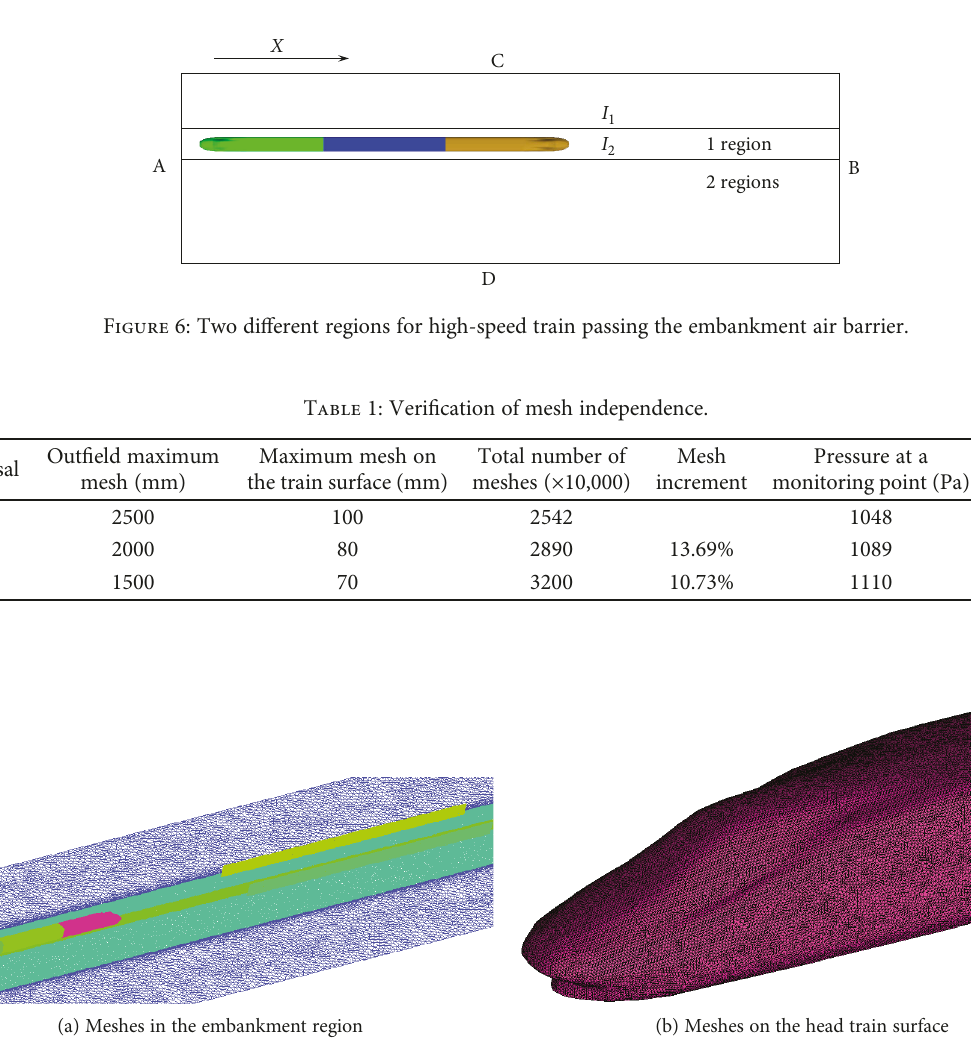
Figure 7: Mesh diagram of the high-speed train running on the